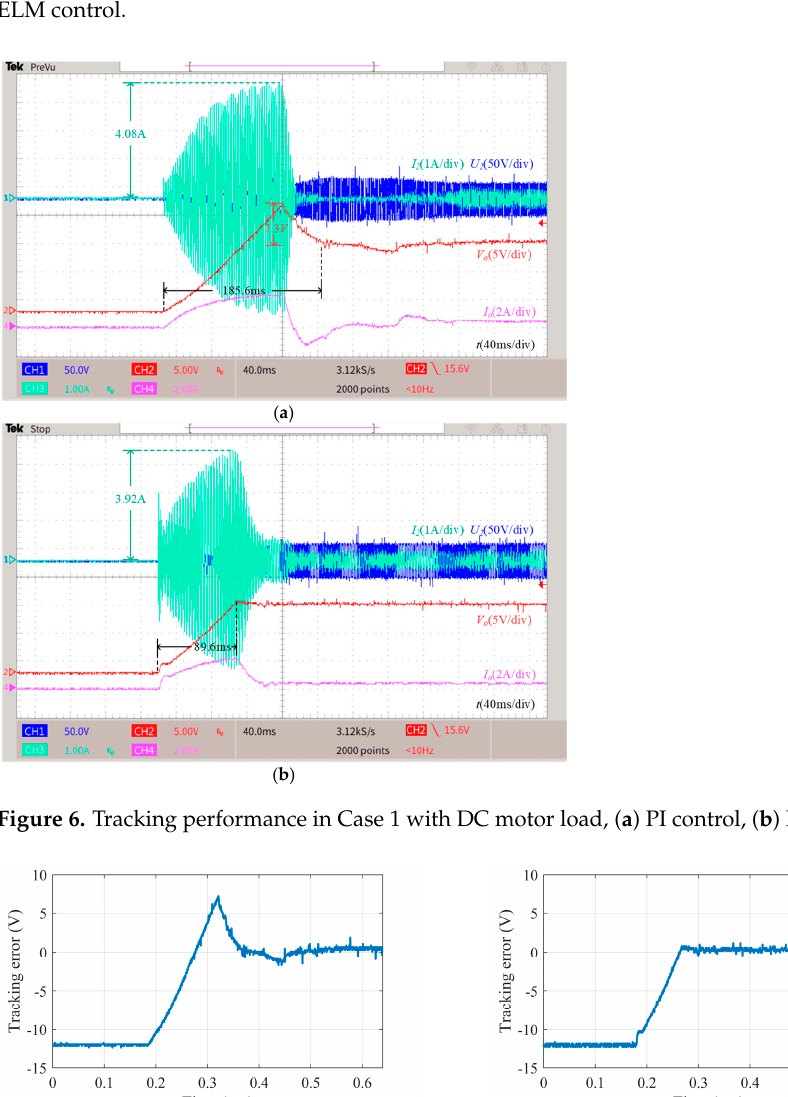
Figure 7. Output voltage tracking error in Case 1 with DC motor load, ( a ) PI control, ( b ) FTSM-ELM control.